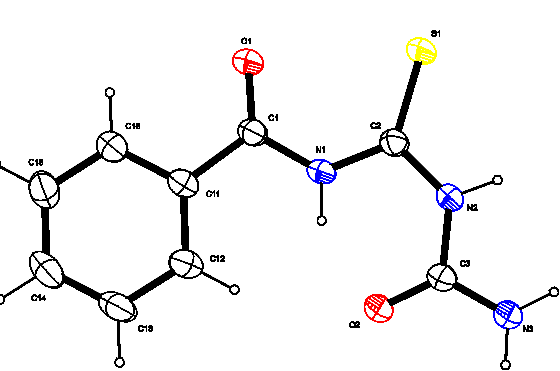
Figure 2: An ORTEP view of 1-((benzamido) sulfanylenemethyl) urea (I) shows 50% probability displacement ellipsoids and the atom labeling.